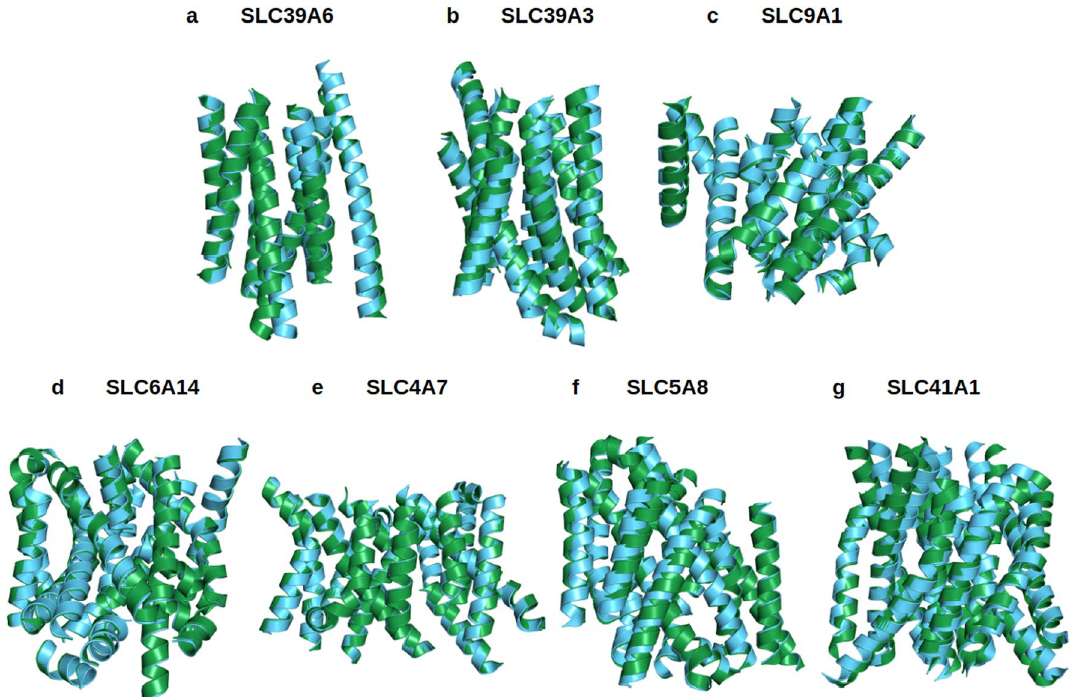
Figure 4. Superposed 7 native solute carrier transporters and their QTY variants that were predicted by AlphaFold2. The native structures (green) and their water-soluble QTY variants (cyan). For the superposed structures, the RMSD is in Å ( ). ( a ) SLC39A6 versus SLC39A6 QTY (0.931 Å) ( b ) SLC39A3 versus SLC39A3 QTY (1.567 Å), ( c ) SLC9A1 versus SLC9A1 QTY (0.905 Å), ( d ) SLC6A14 versus SLC6A14 QTY (0.521 Å), ( e ) SLC4A7 versus SLC4A7 QTY (0.426 Å), ( f ) SLC5A8 versus SLC5A8 QTY (1.593 Å), ( g ) SLC41A1 versus SLC41A1 QTY (1.914 Å). The large N- and C-termini are removed for clarity. Please see Tables 2 and 3. For clarity, N-terminus, C-terminus and large loops are